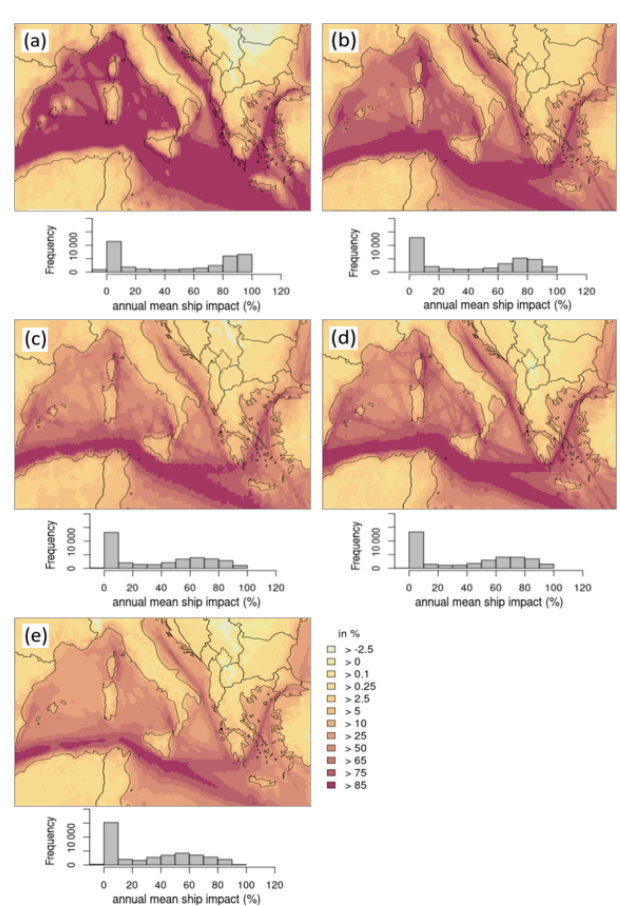
Figure 5. Annual mean NO 2 potential ship impact. (a) CAMx; (b) CHIMERE; (c) CMAQ; (d) EMEP; (e) LOTOS-EUROS. Be- low the domain figure the respective frequency distribution is dis- played for the annual mean NO 2 potential ship impact, referring to the whole model